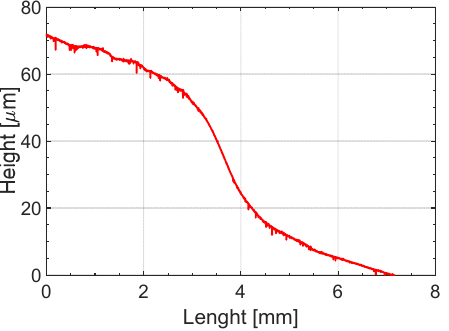
Figure 7. Confocal microscopy measurement of surface swelling of ABS in contact with UPR.